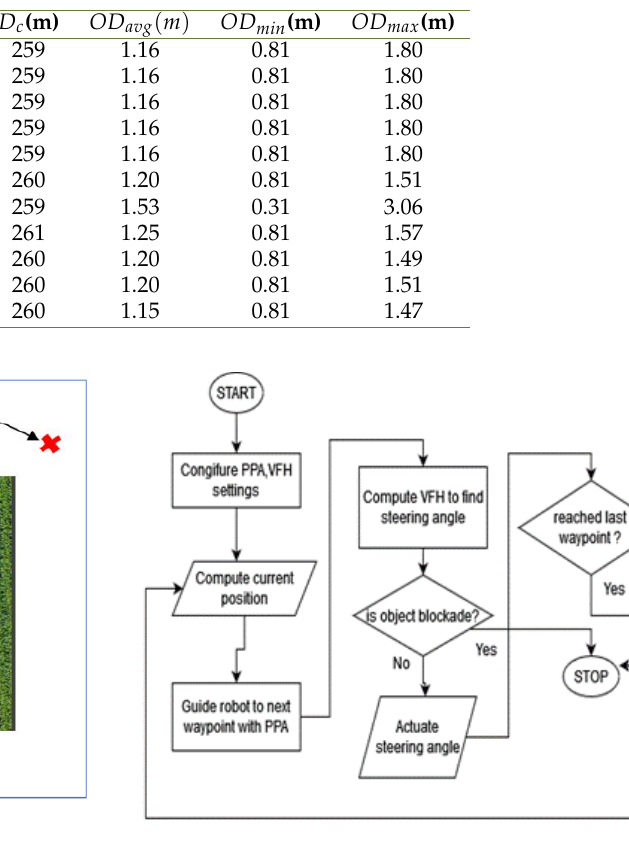
Fig. 3. Flowchart of overall operation.